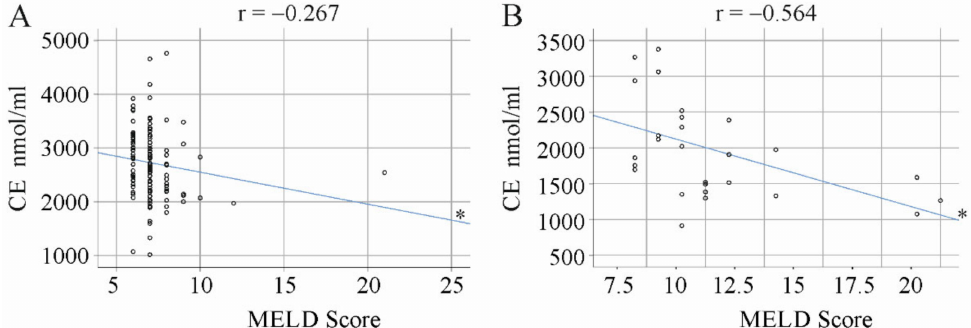
Figure 4. Correlation of total cholesteryl ester (CE) levels with the MELD score. ( A ) Patients without liver cirrhosis, as diagnosed by ultrasound. ( B ) Patients with ultrasound-diagnosed liver cirrhosis. The blue line is the correlation line. * p <